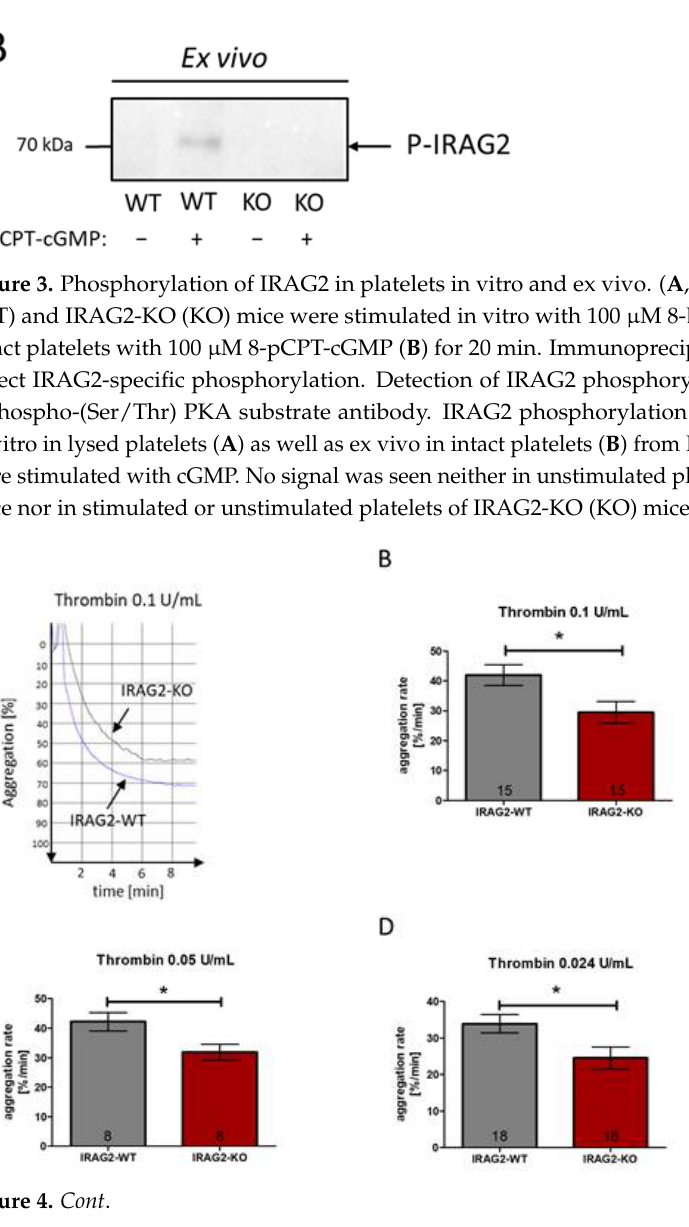
Figure 4. Agonist-induced aggregation of platelets from IRAG2-WT and IRAG2-KO mice. ( A ) Rep- resentative traces for aggregation of IRAG2-WT and IRAG2-KO platelets are shown for stimulation with thrombin 0.1 U/mL, where IRAG2-KO platelets revealed a lower aggregability compared to IRAG2-WT platelets. ( B – D ) Statistical evaluation of aggregability revealed a significantly lower ag- gregation rate for platelets from IRAG2-KO mice compared to platelets from IRAG2-WT mice upon stimulation with thrombin 0.1 U/mL ( B ), thrombin 0.05 U/mL ( C ) and thrombin 0.024 U/mL ( D ). ( E , F ) Representative traces for aggregation of IRAG2-WT and IRAG2-KO platelets upon stimulation with collagen 5 µg/mL ( E ) and statistical evaluation of aggregation rate upon stimulation with col- lagen 5 µg/mL ( F ) showed a significantly lower aggregability of IRAG2-KO platelets compared to IRAG2-WT platelets. Aggregation rate is calculated as maximal slope of the curve. For each aggre- gation 1.0 × 10 8 platelets/mL were used. Number of performed experiments (number of mice) are